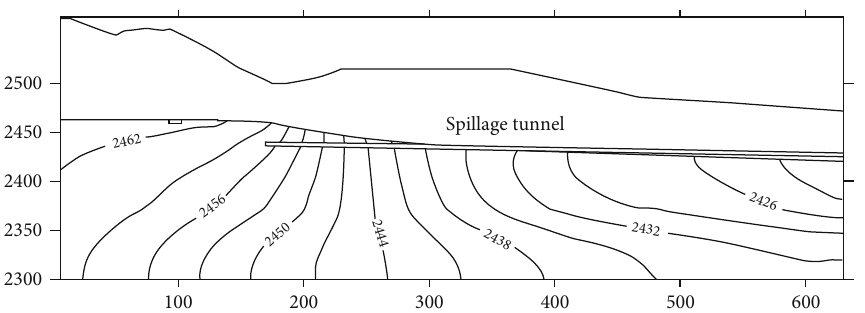
Figure 15: The isopotential distribution map of seepage fi eld about dam foundation (15-15 pro fi le).